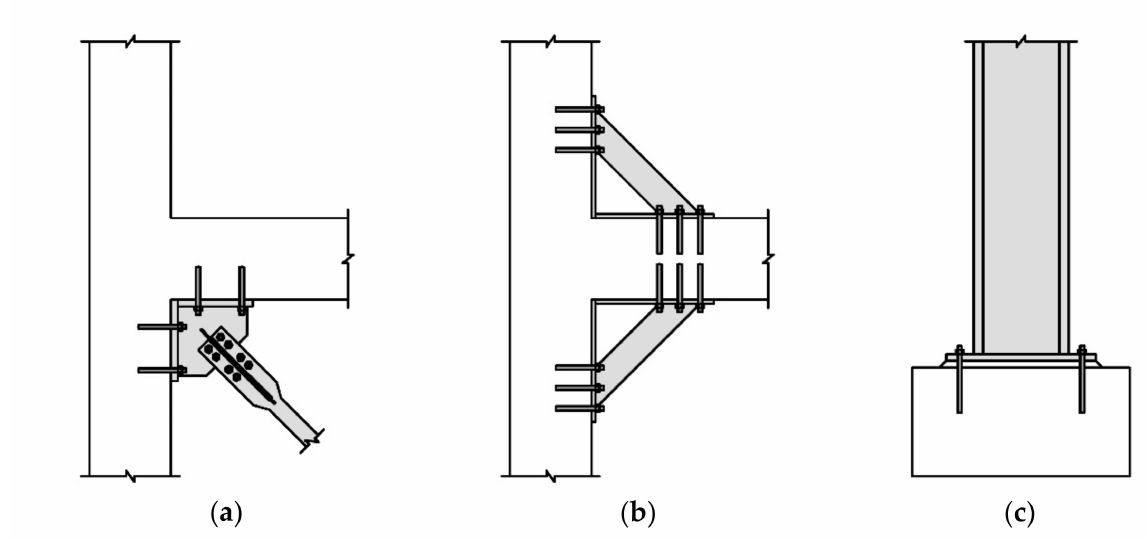
Figure 1. Connections between structural steel elements and RC structures: ( a ) steel bracing to RC frame; ( b ) steel haunches to RC frame; ( c ) steel column to